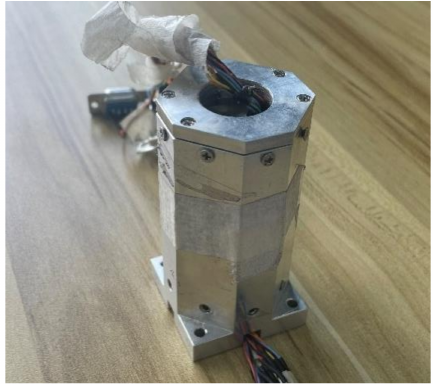
Figure 8. Magnetic measurement system.